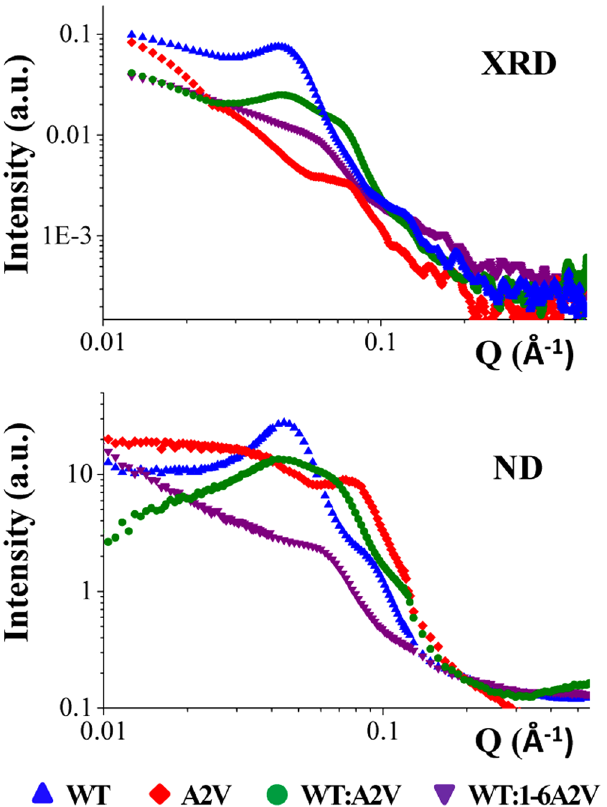
Figure 2. Comparison of equatorial x-ray (XRD) and neutron diffraction (ND) scatter from the WT, A2V, WT:A2V, WT:1-6A2V